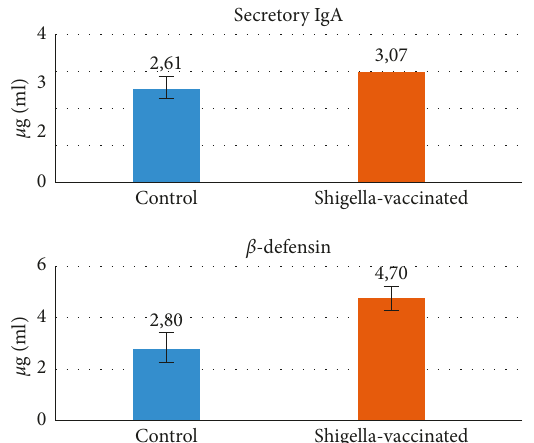
Figure 6: Compared to control, the difference in secretory IgA and β -defensin is secondary to Shigella